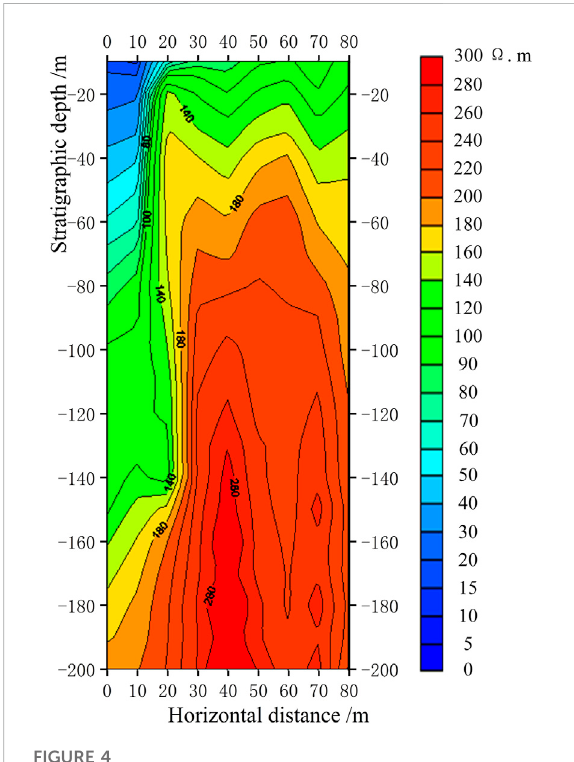
FIGURE 4 Longitudinal section view of resistivity of X 1